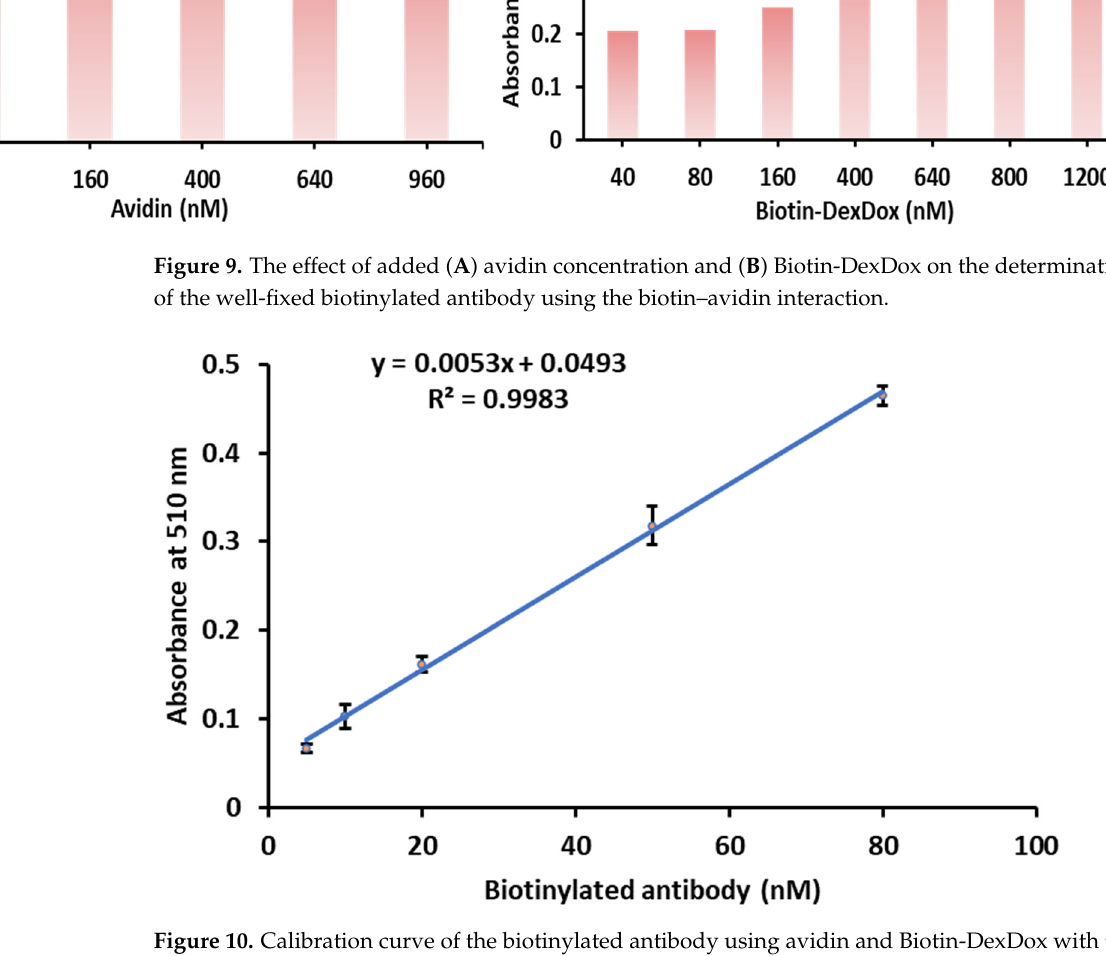
Figure 10. Calibration curve of the biotinylated antibody using avidin and Biotin-DexDox with the optimized conditions for the colorimetric INT assay.